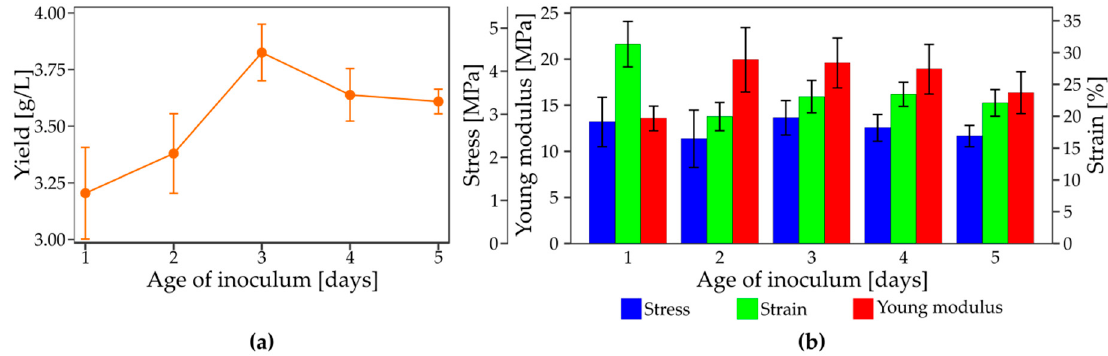
Figure 6. Impact of age of inoculum on ( a ) biosynthesis yield and ( b ) tensile parameters of bacterial nanocellulose.